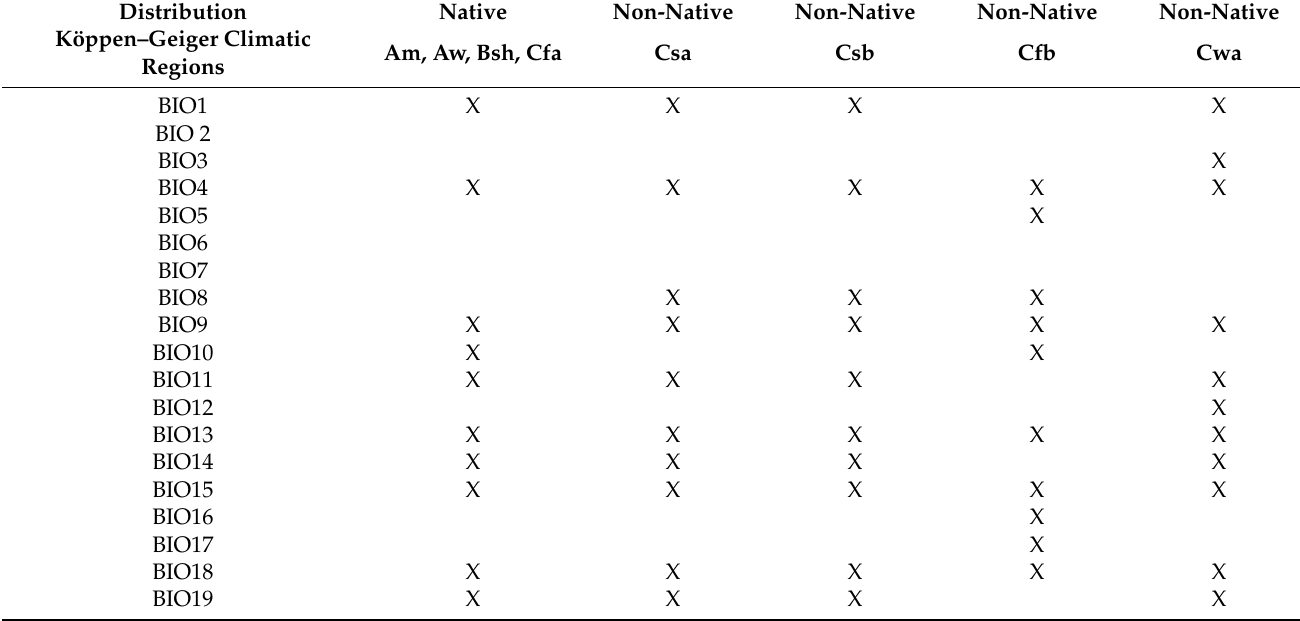
Table 1. Bioclimatic variables selected for each of the corresponding Köppen–Geiger climatic regions of the species distribution areas. Bio1: Annual Mean Temperature, Bio3: Isothermality (BIO2/BIO7) ( × 100), Bio4: Temperature Seasonality (standard deviation × 100), Bio8: Mean Temperature of Wettest Quarter, Bio9: Mean Temperature of Driest Quarter, Bio10: Mean Temperature of Warmest Quarter, Bio11: Mean Temperature of Coldest Quarter, Bio12: Annual Precipitation, Bio13: Precipitation of Wettest Month, Bio14: Precipitation of Driest Month, Bio15: Precipitation Seasonality (Coefficient of Variation), Bio16: Precipitation of Wettest Quarter, Bio17: Precipitation of Driest Quarter, Bio18: Precipitation of Warmest Quarter, Bio19: Precipitation of Coldest Quarter. The native distribution of O. drummondii includes four of the eight Köppen–Geiger climatic regions: Tropical monsoon climate (Am), Tropical savanna climate with dry-winter characteristics (Aw) hot semi-arid climate (Bsh), and Humid subtropical climate (Cfa). Therefore, the variables selected for these climatic regions correspond to the native distribution. The invasion zones are the four remaining climates: Mediterranean hot summer climates (Csa), Mediterranean warm/cool summer climates (Csb), Temperate oceanic climate (Cfb), Dry-winter humid subtropical climate